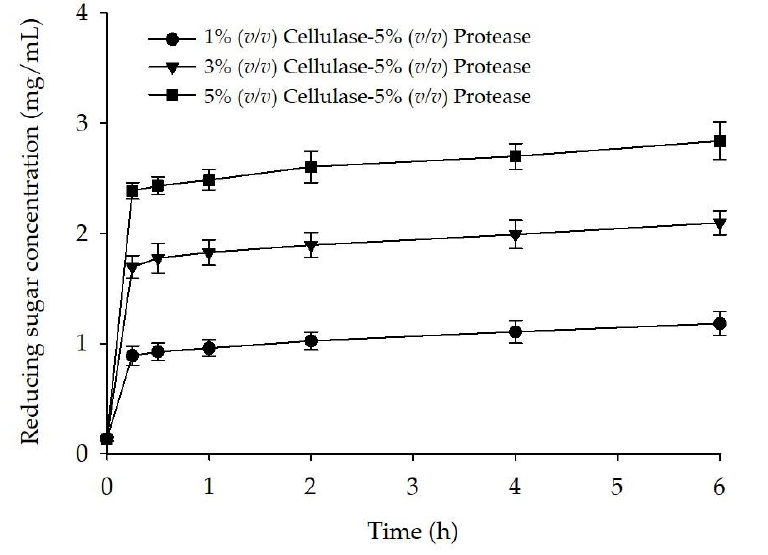
Figure 1. Time course of reducing sugar release during the enzymatic digestion of G. fisheri .